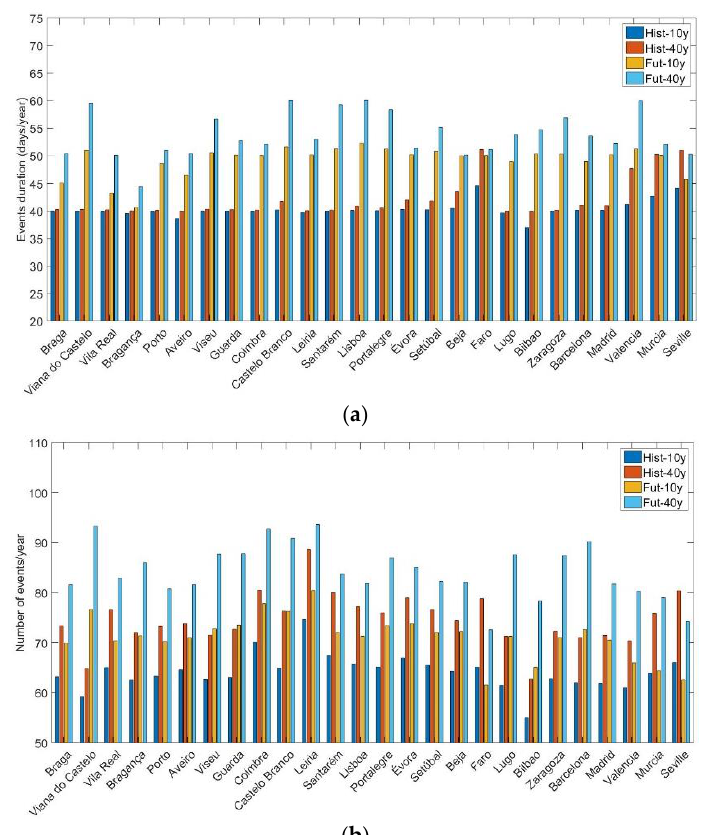
Figure 26. Comparison of the ( a ) event duration (days/year) and ( b ) the number of events (year) in the historical (blue) and future (red) period for extreme events with a return period of 10 years (full line) and 40 years (dashed line) for helicity (0–6 km).